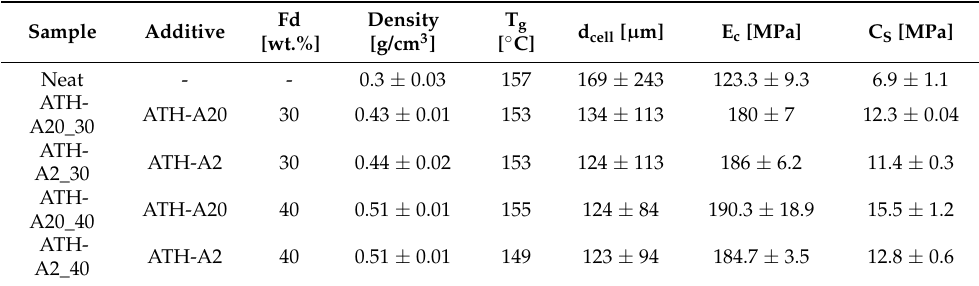
Table 2. Summary of ATH flame retardants used in this study. Particle size derived from technical data sheets